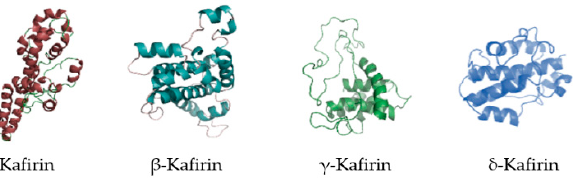
Figure 1. Kafirin structure. Image adapted from Zhu et al. [8] with permission from Elsevier.